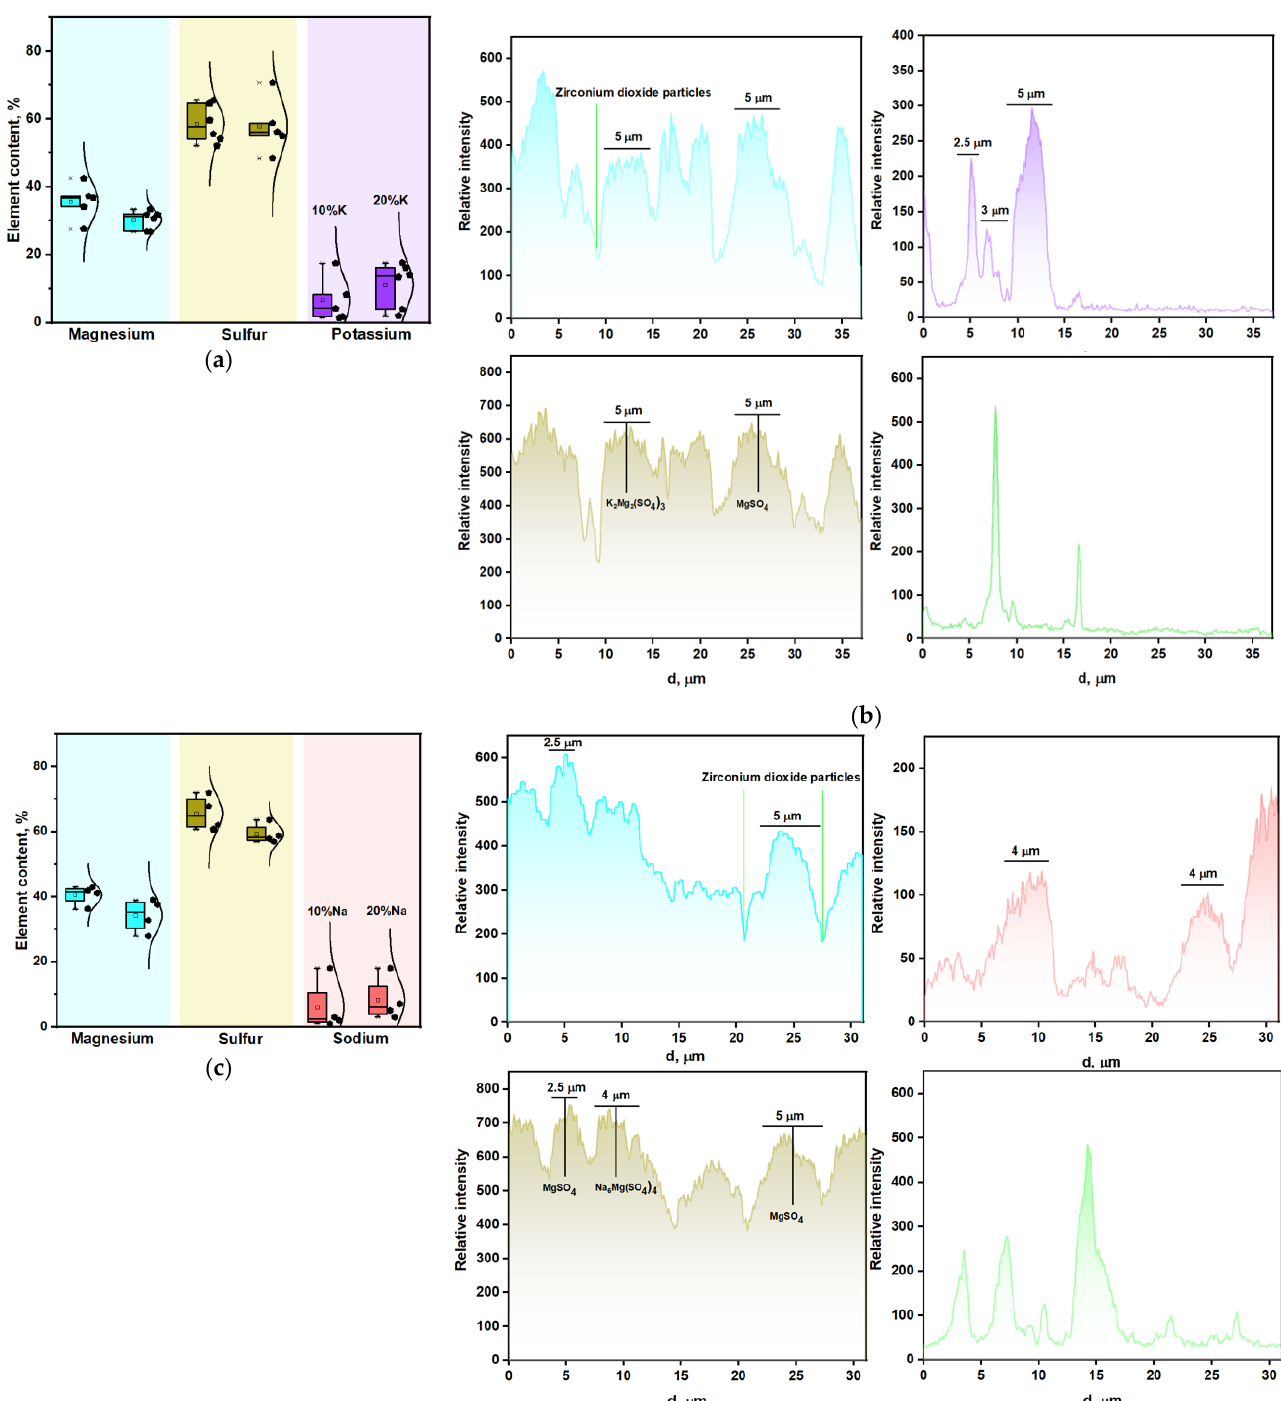
Figure 5. ( a , c ) Element content in Mg10KY-TZP and Mg20KY-TZP, and Mg10NaY-TZP and Mg20NaY-TZP samples according to EDX; ( b , d ) elemental line scans of the Mg10KY-TZP and Mg10NaY-TZP samples.